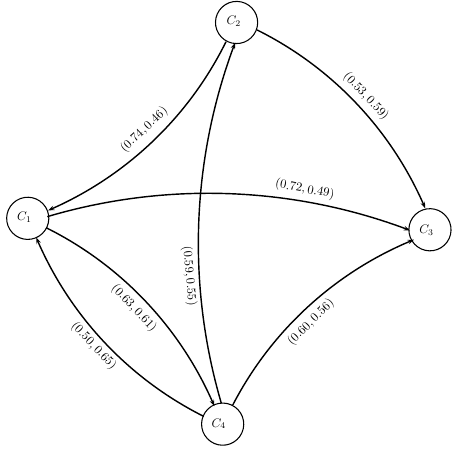
Figure 15. Partial directed network of the fused